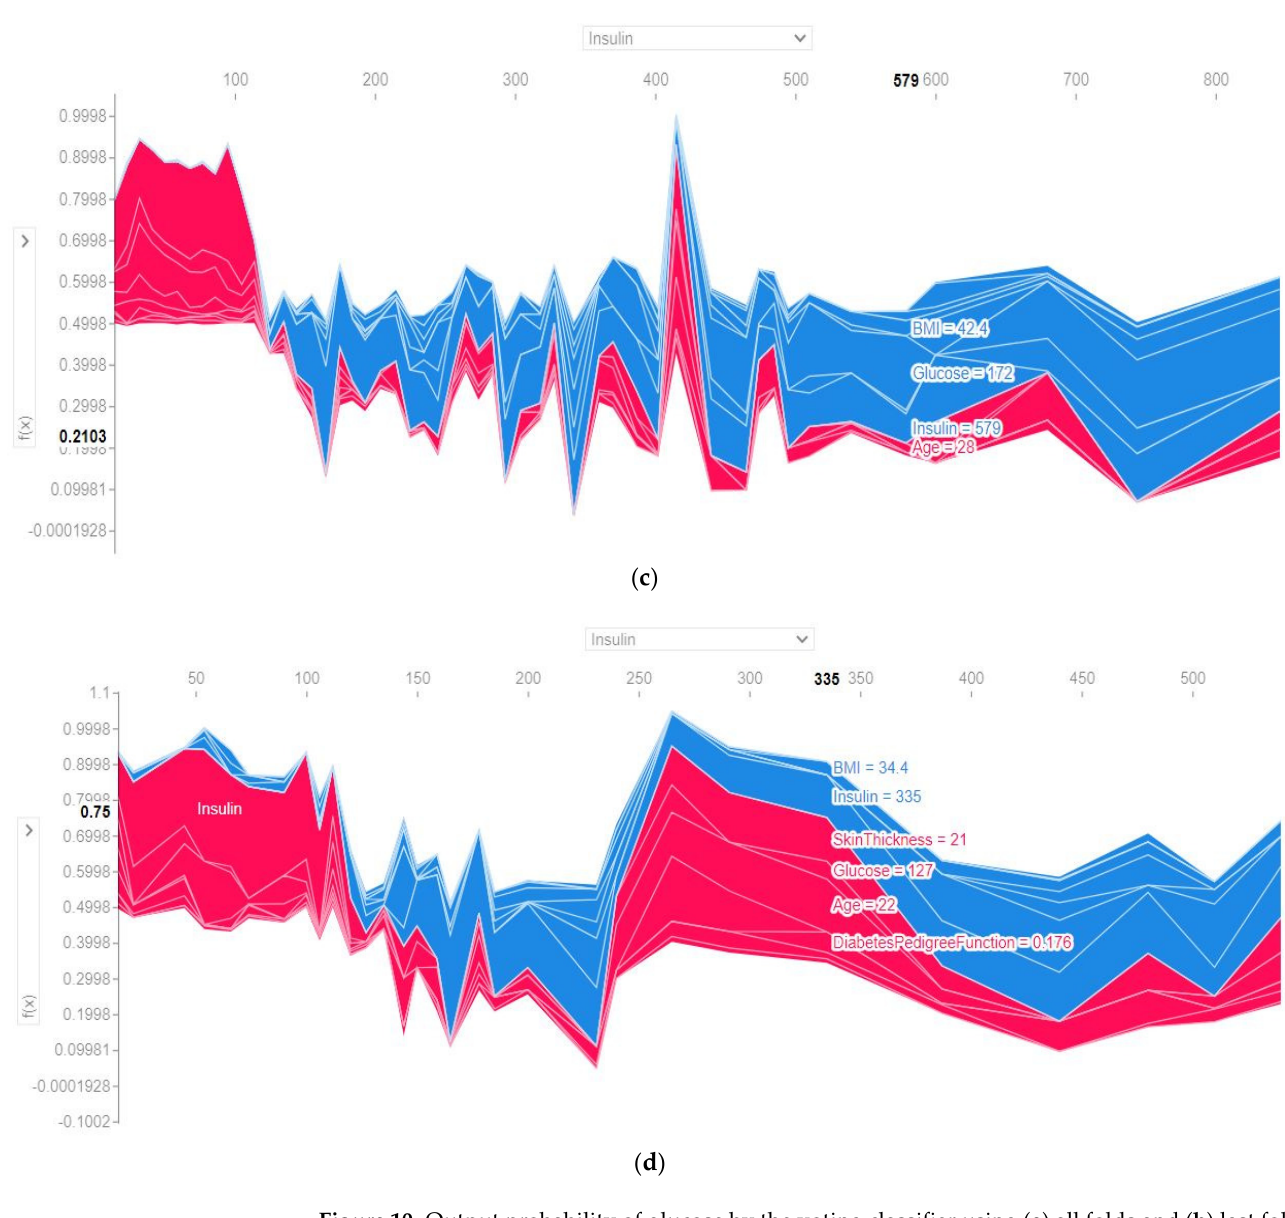
Figure 10. Output probability of glucose by the voting classifier using ( a ) all folds and ( b ) last fold and output probability of insulin by the voting classifier using ( c ) all folds ( d ) last fold.